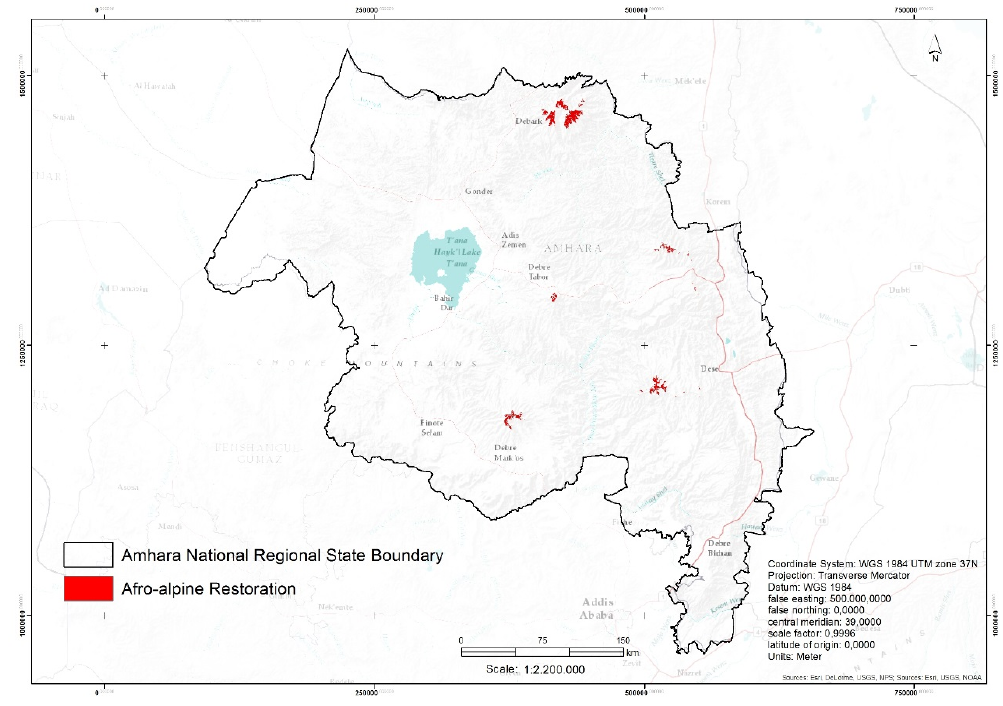
Figure 6. Opportunity areas for afro ‐ alpine restoration.